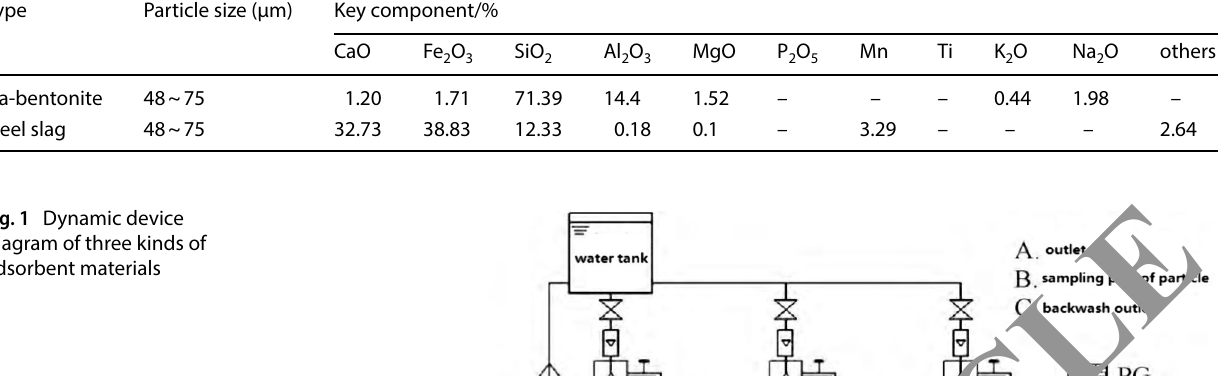
Table 4 The data of bentonite and steel slag